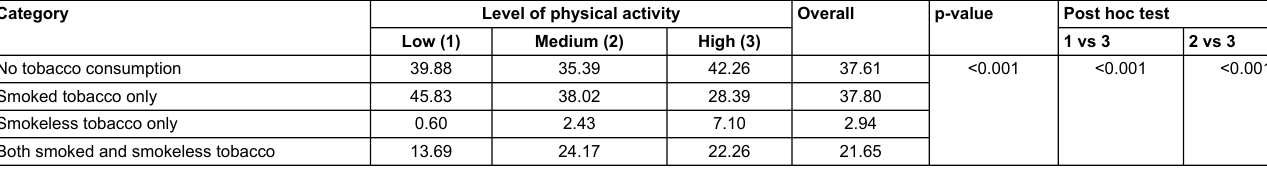
Table 5: Relationship between smoked and smokeless tobacco consumption during the last 12